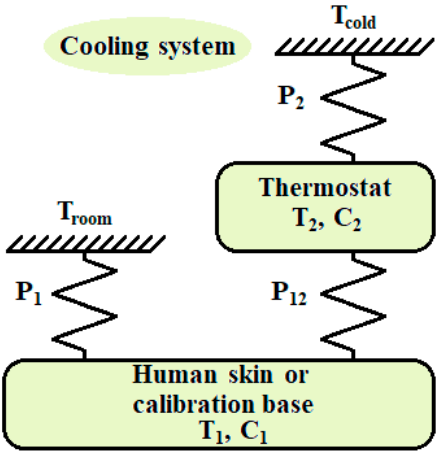
Figure 2. Calorimetric sensor model.